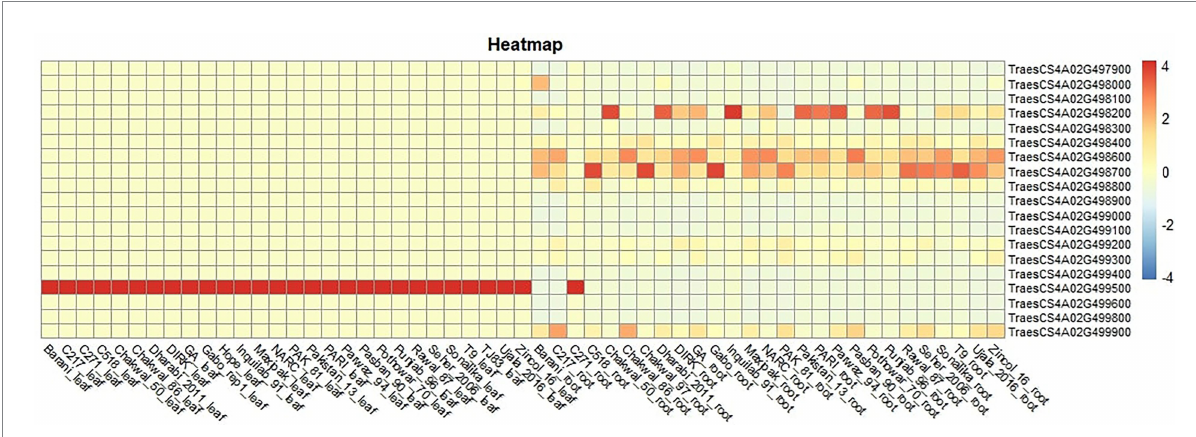
TaHST1 locus plays a significant role in heat stress tolerance at both seedling and reproductive stage. Twenty-four haplotypes were detected using a set of five primers to detect TaHST1 locus Among the most frequent haplotypes, hap-20 had the highest SW